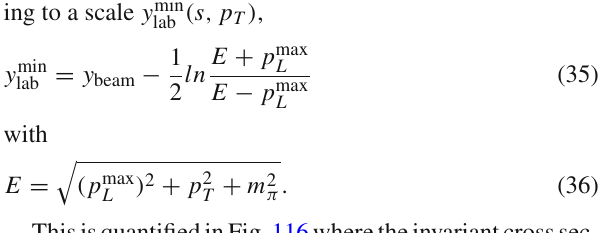
The invariant cross sections f ( x (cid:3) Figs. 117, 118 and 119 as a function of x (cid:3) p T